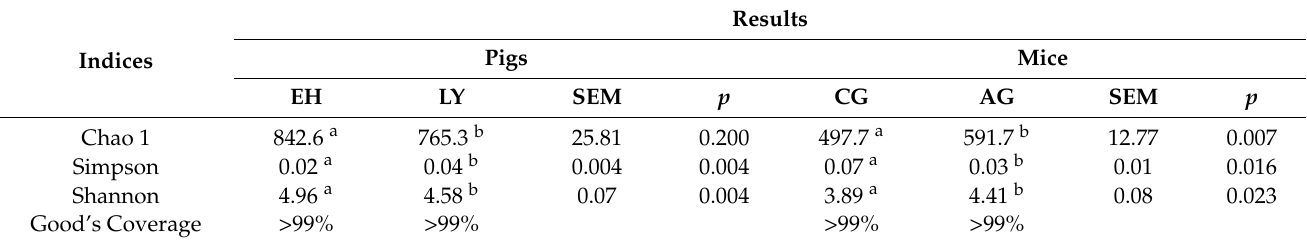
Table 2. Alpha diversity indices of fecal bacteria of pigs and